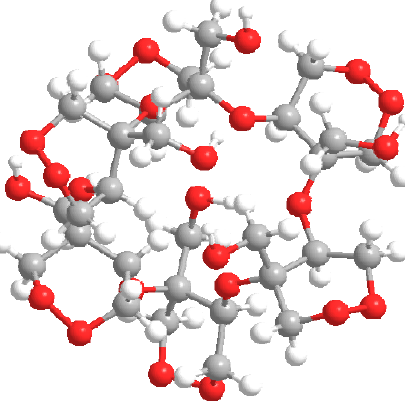
Figure 2. Kramecyne. The 3D structure was optimized at the B3LYP/6-31G level of